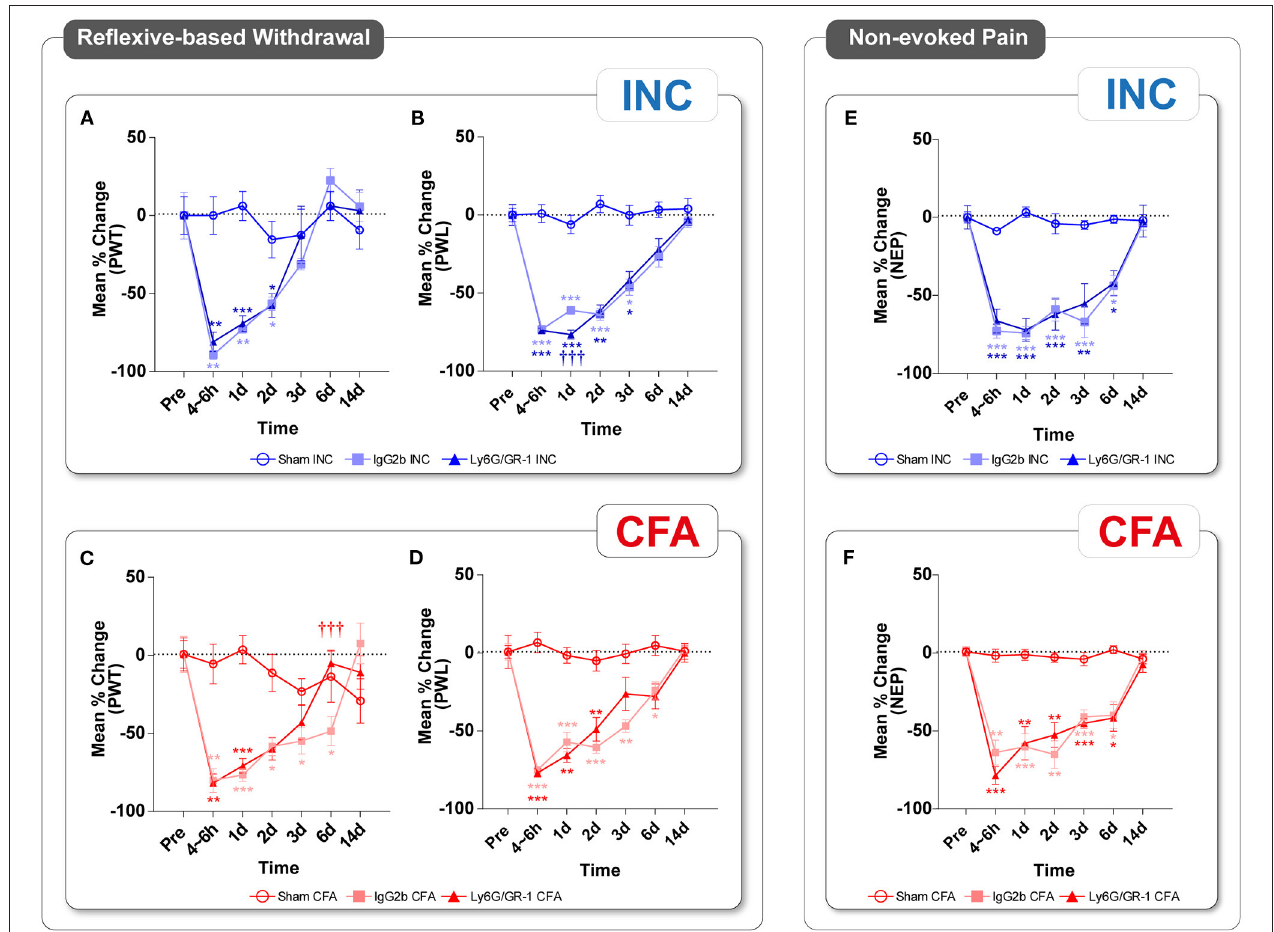
FIGURE 3 | Multidimensional pain-related behavior after plantar incision or CFA. Trajectories of reflex-based withdrawal behavior (A–D) , including punctate mechanical PWT to mechanical stimuli and PWL to heat stimuli, and (E,F) NEP behavior, were determined in INC and CFA. PWT (A,C) and PWL (B,D) peaked at 4–6h in both pain models but showed differences in their duration. NEP (E,F) was decreased in the acute phase and lasted up to day 6 in both pain entities. Ly6G/GR-1 antibody treatment attenuated PWT in CFA at day 6 and exacerbated PWL at 1 day in INC. Sham-mice showed no changes. All experimental groups contain eight mice (cohort 2). The results are expressed as mean ± SEM. Values of p : * p < 0.05, ** p < 0.01, *** p < 0.001 vs. Pre, † p < 0.05, †† p < 0.01, ††† p < 0.001 vs. Vehicle (IgG) by Kruskal–Wallis and Dunnett’s multiple comparison